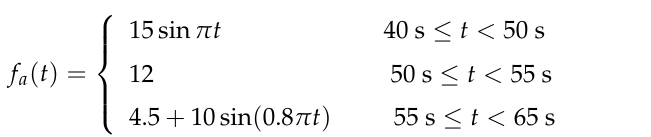
Figure 7 is a simulation comparison of actuator faults and their reconstructed